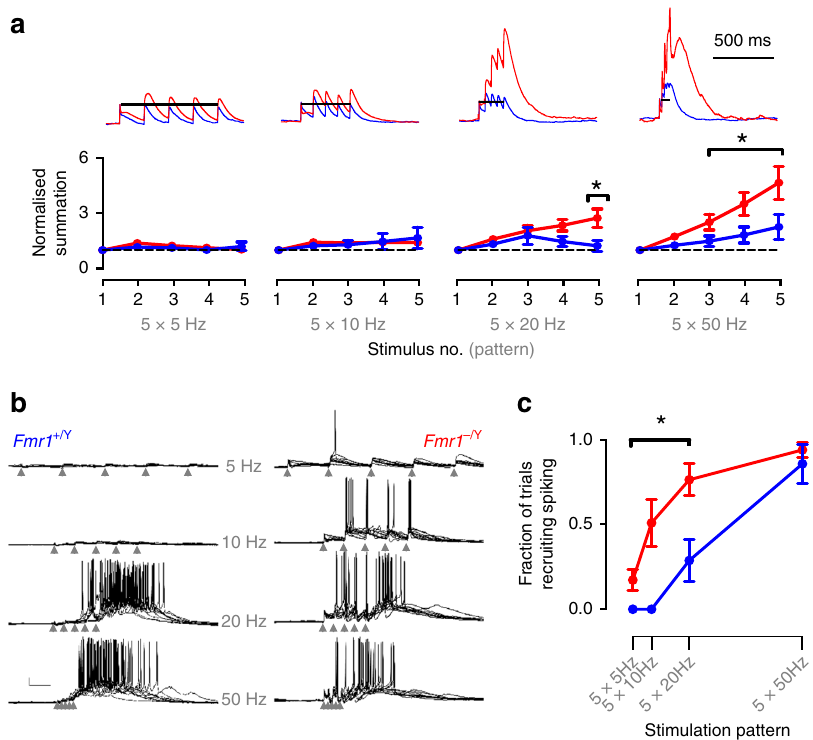
Fig. 5 Relaxed coincidence detection impairs frequency gating in Fmr1-KO L4 networks. a Hyper-summation of high-frequency thalamocortical input in Fmr1 − /Y SCs. Top: example current-clamp recordings showing voltage summation in response to fi ve regular stimuli at frequencies between 5 and 50 Hz. Amplitude is normalized to that of steady-state EPSP. Below: Mean ± SEM normalised EPSP amplitude as a function of stimulus number. Short trains of TC stimuli at 20 and 50 Hz evoked stronger voltage summation in Fmr1 − /Y recordings: asterisks denote signi fi cantly elevated responses ( p < 0.05, unpaired t - test, Fmr1 + /Y n = 7, Fmr1 − /Y n = 7). b Shifted sensitivity of L4 network to thalamocortical input frequency in Fmr1-KOs . Example current-clamp